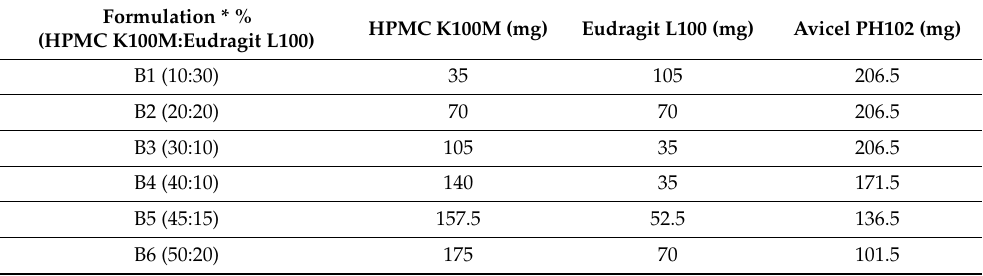
Table 14. The formulations of B1 to